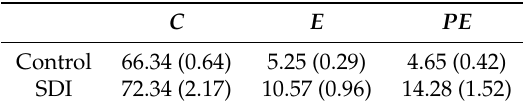
Table 5. Mean scoring measures ( SE in